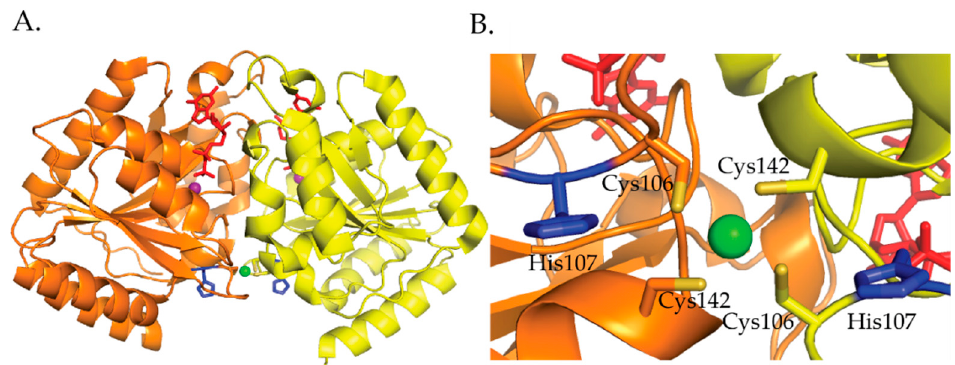
Figure 10. ( A ) Crystal structure of H. pylori HypB (PDB ID 4LPS) [114]. Prior to crystallization, the protein was incubated with Guanosine 5’- O -(3-thiotriphosphate) (GTP γ S) and magnesium chloride before adding nickel chloride [114]. The protein monomers are colored orange and yellow, guanosine diphosphate (GDP) molecules are shown as red spheres, the magnesium ions are shown as purple spheres, and the nickel ion is shown as a green sphere, ( B ) Close-up of the bridging G-domain metal site with a nickel ion bound. (This figure was adapted from Sydor et al [114]. The research was originally published in the Journal of Biological Chemistry. Sydor, A.M.; Lebrette, H.; Ariyakumaran, R.;